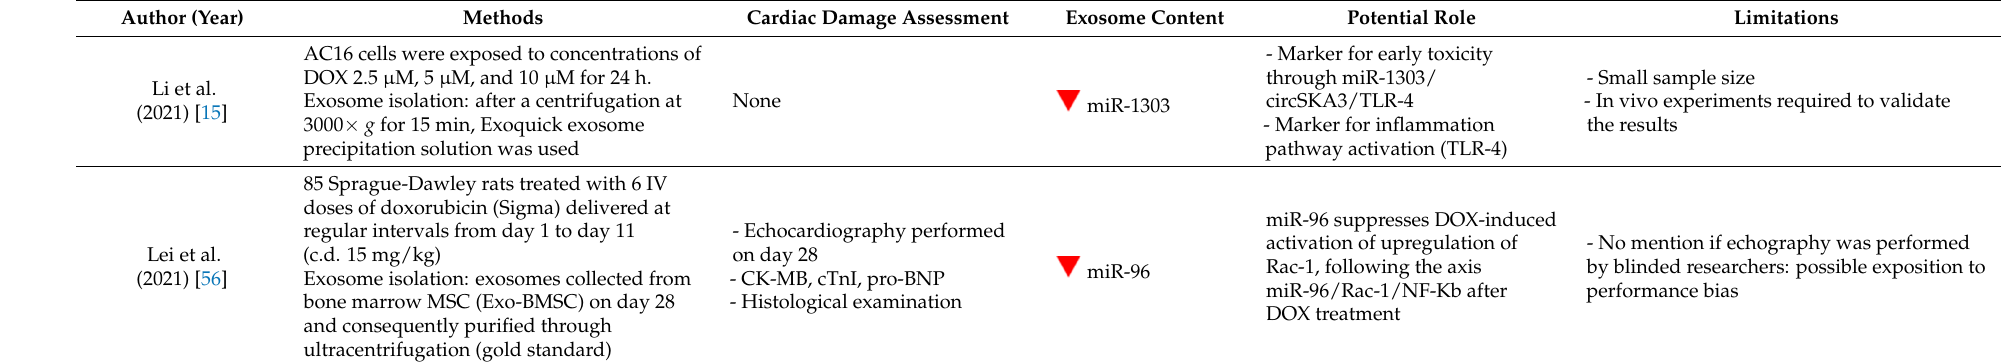
tricular Sistolic Pressure; N.C.D.: not correlated with cardiac damage; rCPCs: rat Cardiac Progenitor Cells; RAOECs: Rat Aortic Endothelial Cells, Wks: weeks. Decreased expression; Increased expression.